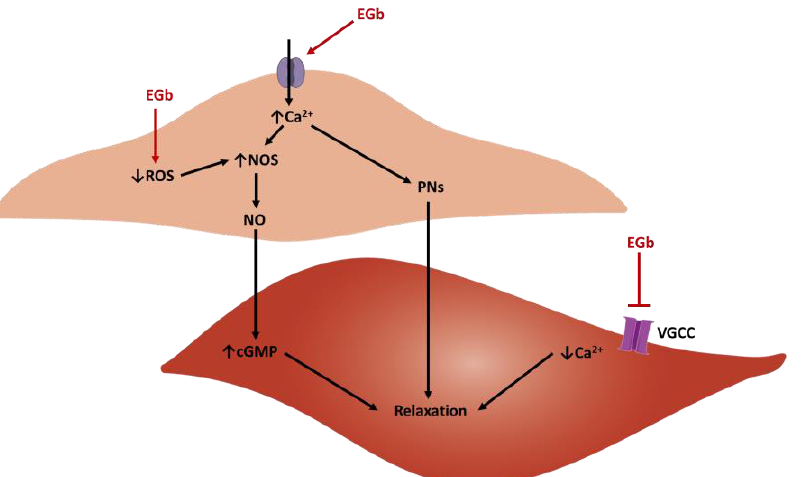
Figure 4. Scheme of the probable vasorelaxation mechanisms of the extracts of Ginkgo biloba (EGb). An endothelial cell is represented on top and a vascular smooth muscle cell at the bottom (cGMP — cyclic guanosine monophosphate; NO — nitric oxide; NOS — nitric oxide synthase; PNs — prostanoids; ROS — reactive oxygen species; VGCC — voltage-gated calcium channel). EGb